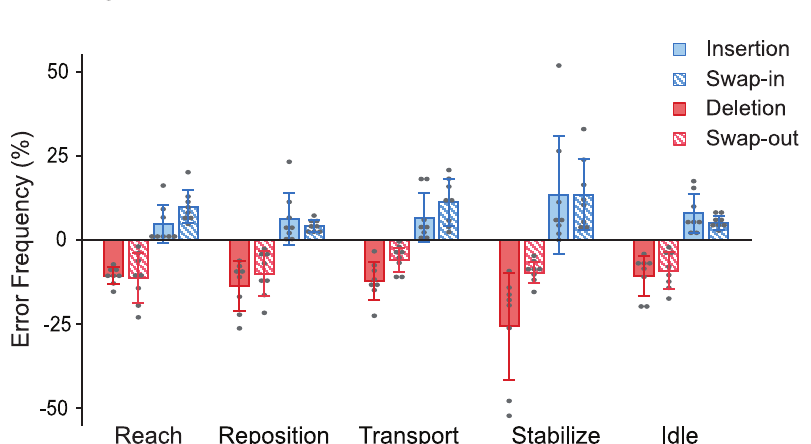
Fig 4. Prediction errors by Seq2Seq. (A) Sequence matching .Shown is a schematic depicting the different types of prediction outcomes, comparing the ground truth sequence (top row) against the predicted sequence (bottom row). Seq2Seq could produce a true positive (correct prediction; green), false negative (deletion or swap-out error; pink), or false positive (insertion or swap-in error; blue). In the example shown, transport was correctly predicted; stabilize was incorrectly deleted; reach was incorrectly swapped-out while idle was incorrectly swapped-in; and reach was incorrectly inserted. (B) Frequency of prediction errors per primitive class . Shown are the mean frequency ± standard deviation of prediction errors for patients in the test set; each dot represents a single subject. Activities were combined, and erroneous counts were normalized to ground truth counts in each primitive class. Deletion errors happened when primitives were incorrectly removed from the prediction, and occurred with modestly low frequency, except for stabilizations. Swap-out errors happened when primitives were incorrectly removed from the prediction and instead predicted as another class, and occurred with modestly low frequency. Insertion errors happened when primitives were incorrectly added to the prediction, and occurred with low frequency, except for stabilizations. Swap-in errors happened when primitives were incorrectly predicted instead of the actual primitive class, and occurred with modestly low